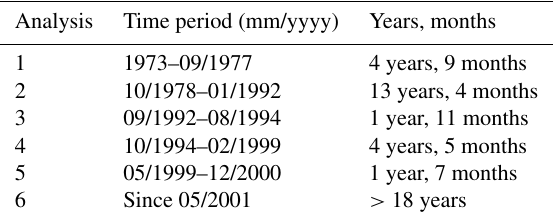
Table 3. Analyses within the Sylt Roads hydrochemistry time se-